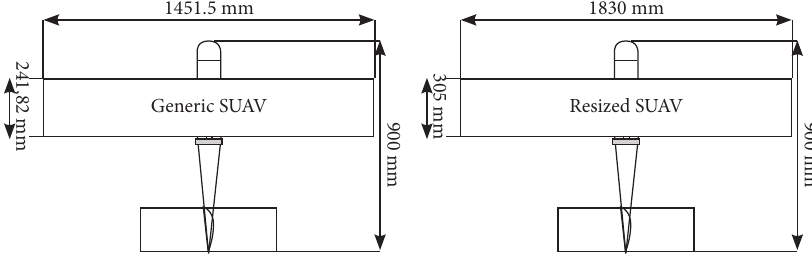
Figure 9. Conceptual representation of